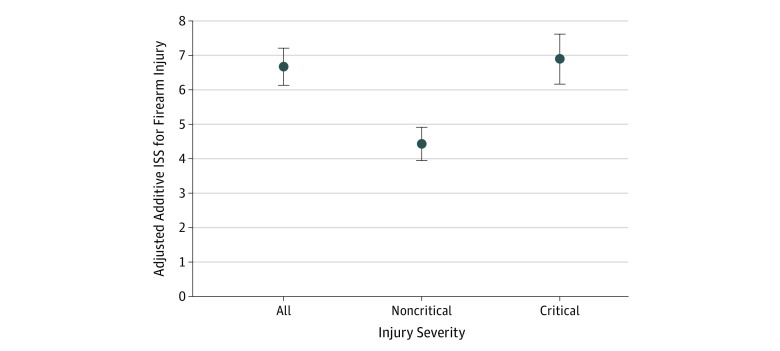
Adjusted Additive Higher Injury Severity Score (ISS) Associated With Firearm Compared With Cut or Pierce InjuriesCompared with cut or pierce injuries, firearm injuries had a 6.7-point (95% CI, 6.1-7.2; P < .001) higher ISS for all injuries, a 6.9-point (95% CI, 6.2-7.6; P < .001) higher score for critical injuries, and a 4.4-point (95% CI, 3.9-4.9; P < .001) higher score for noncritical injuries. Error bars indicate 95% CI.